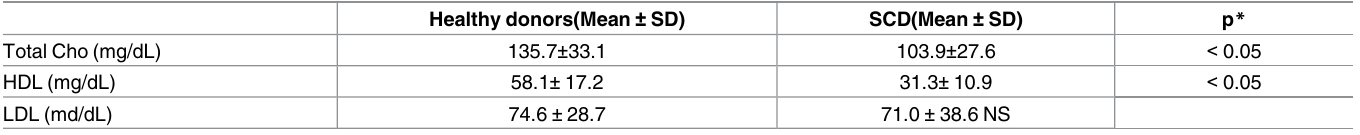
Table 1. Lipid profiles of the plasma from 32 sickle cell disease (SCD) patients and 28 healthy normal donors.